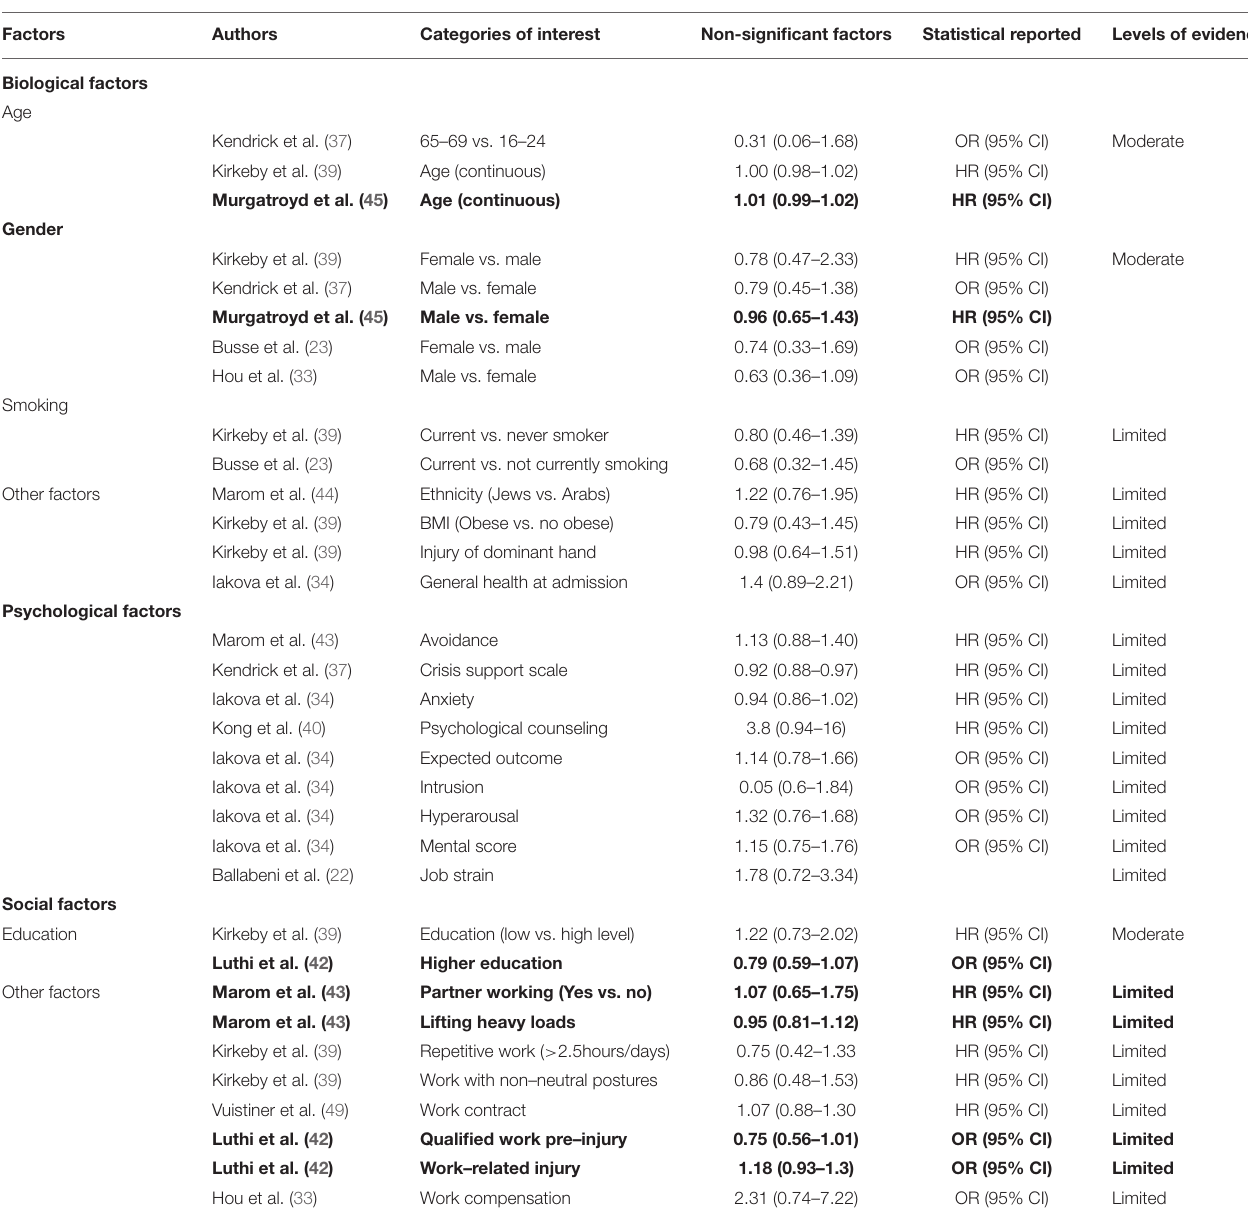
TABLE 6 | Non-significant factors for RTW in the late phase ( > 6 month) postinjury.